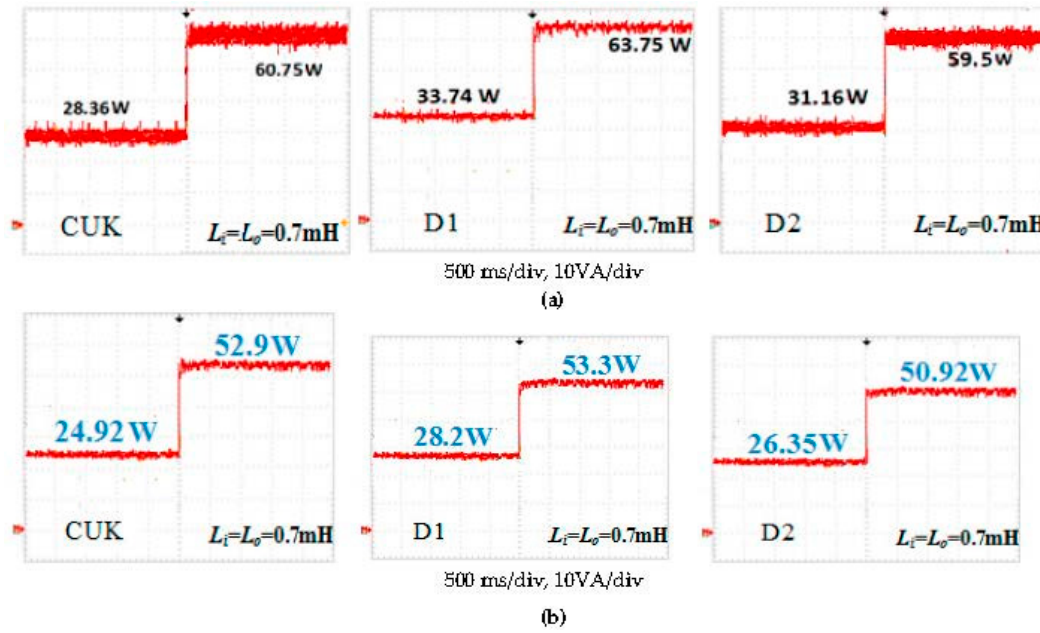
Figure 11. Experimental results of CUK, D1 and D2 converters at 0.7 mH: ( a ) PV power; ( b ) average load power.